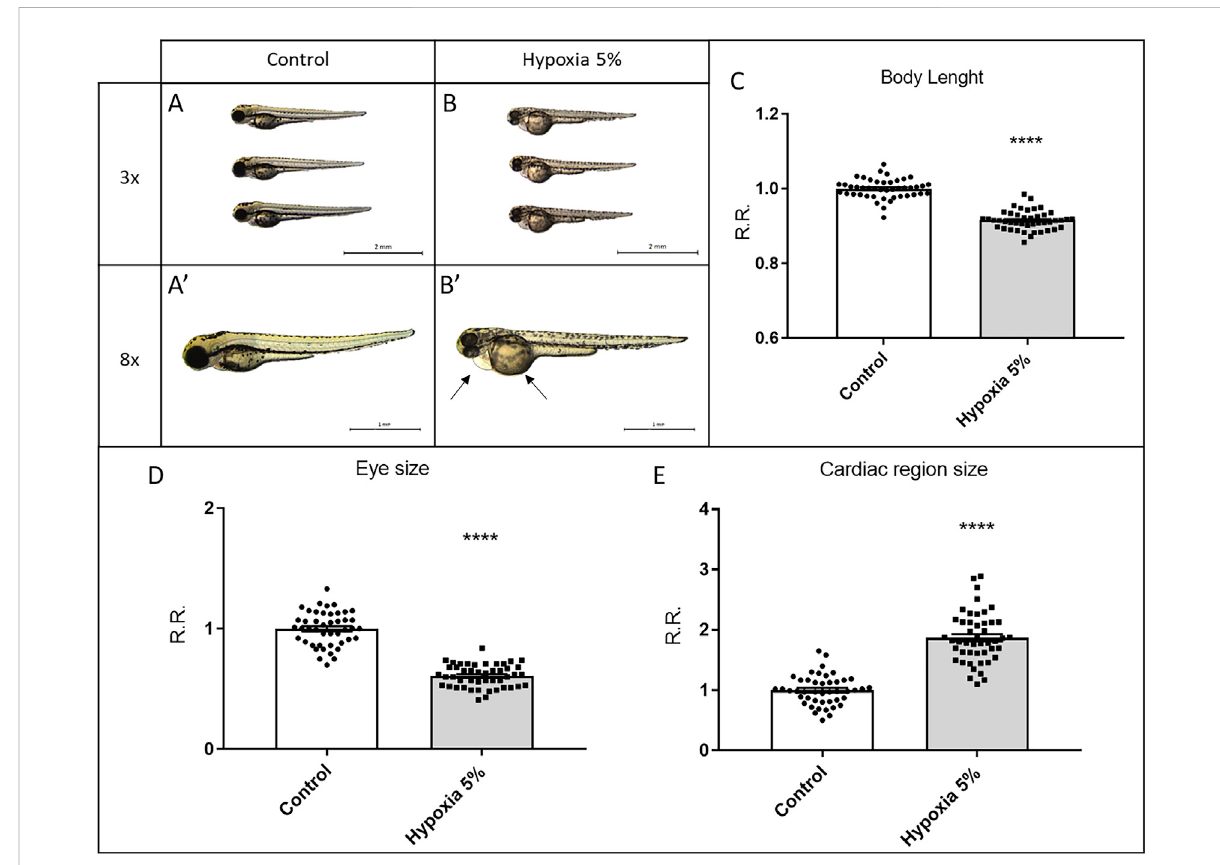
FIGURE 2 Long-term hypoxiatreatmentleadsto growth restriction inzebra fi sh embryos. (A – E) Morphological analysis of3-dpfzebra fi sh embryosafter a long-term (2-days long) treatment in 5% hypoxia; hypoxia-treated embryos display reduced body length (A – C) and ocular size (D) , poorly absorbed yolkand apericardial effusion(arrows inB ′ )leading to asigni fi cant enlargementof thecardiac region size (E) . All embryos are inlateral view,anterior to the left. Sample size: n = 45; **** = p < 0.0001; R.R. = Relative Ratio. Test: Unpaired